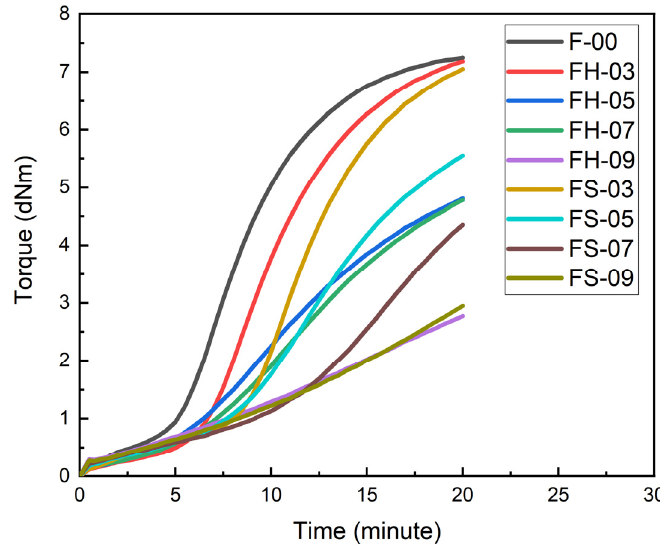
( b ) Figure 4. ( a ) Thermogravimetric analysis of RH native, RH (HCl-pretreated), silica, and silica– lignin hybrid and ( b ) DTG analysis of RH native, RH (HCl-pretreated), silica, and silica–lignin hy- brid. 3.2. Natural Rubber Foam (NRF) 3.2.1. Cure Characteristics of Natural Rubber Compound The cure curves and curing characteristics of the natural rubber compounds at 150 °C are presented in Figure 5 and Table 6, respectively. Introducing filler to the natural rubber compounds reduced the maximum torque in both the silica–lignin hybrid and silica samples. The maximum torque of natural rubber compounds decreased along with the increase in phr (part per hundred rubbers) of the filler. This was probably attributed